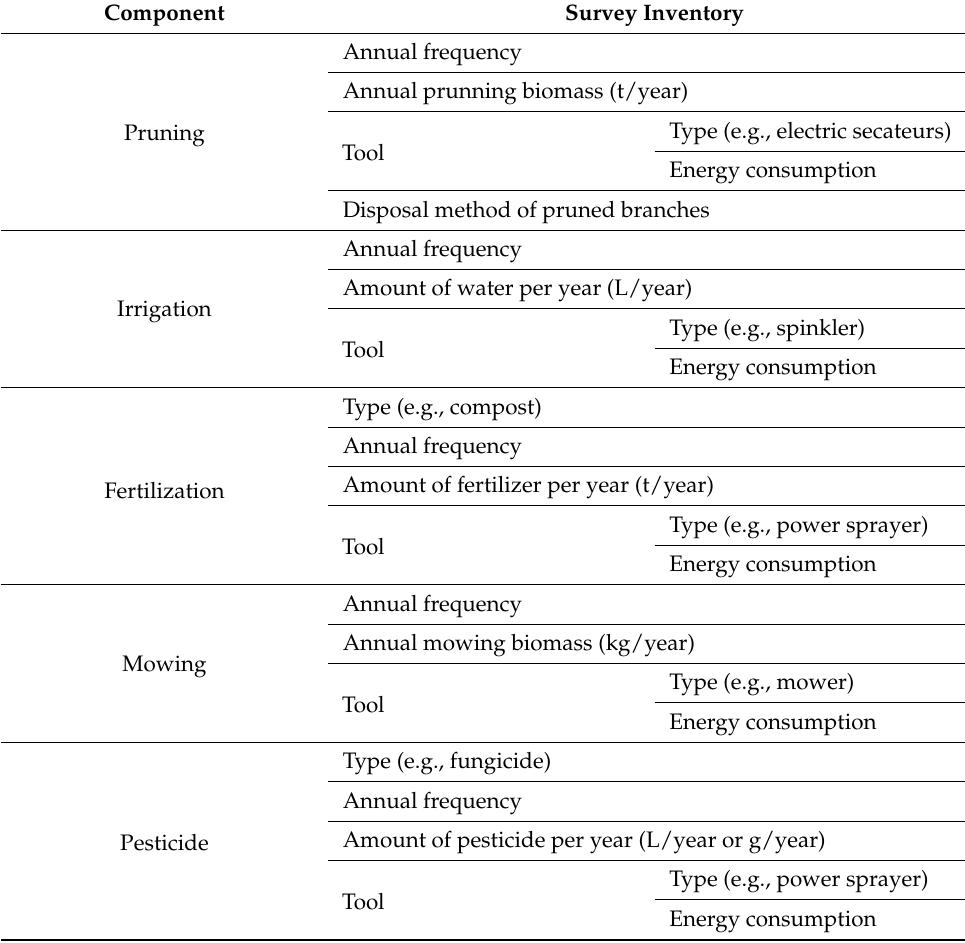
Table 1. Survey inventory used to calculate the carbon emissions of management in study